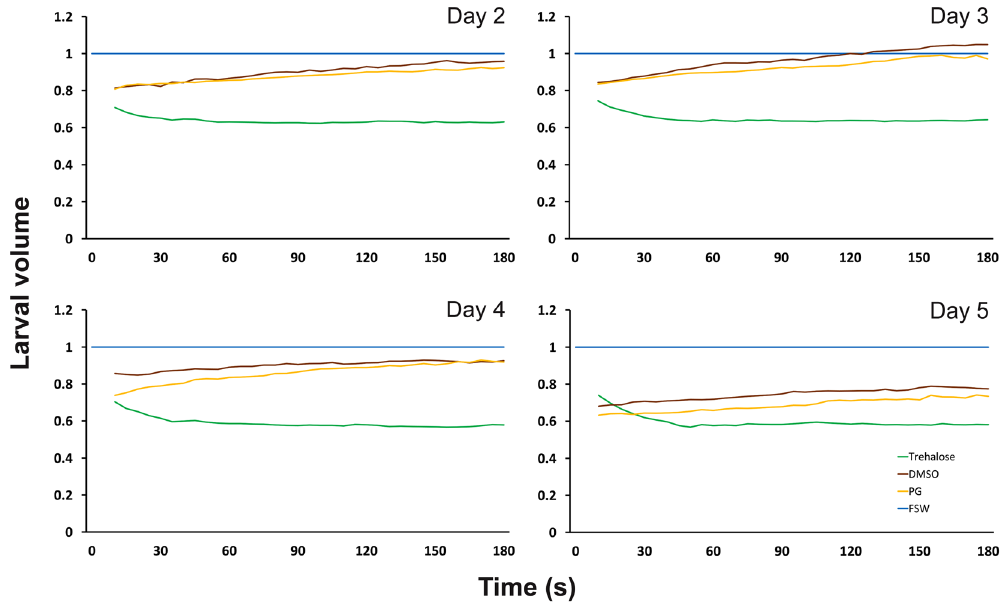
Figure 2. Changes in larval volume in response to the permeating cryoprotectants dimethyl sulfoxide (DMSO; 10% v/v in FSW; brown) and propylene glycol (PG; 10% v/v in FSW; yellow), and the non-permeating cryoprotectant trehalose (0.75 M in 50% FSW, green), compared to control larval volume in filtered seawater (blue), over a three-minute period. A reduction in larval volume was observed within 1 minute of exposure to permeating and non-permeating cryoprotectants on all four days. Increasing larval complexity affected the permeability of DMSO and PG from Day 2 to Day 5. Permeation of DMSO and PG caused larval volume to return to the control volume within the 3-minute analysis period on Days 2 and 3, but larval volume only returned to 85–90% of control volume on Day 4 and 75–80% on Day 5. Volumes are expressed as a proportion of the mean larval volume in FSW for a given day, and each data point is a mean of n ≥ 10